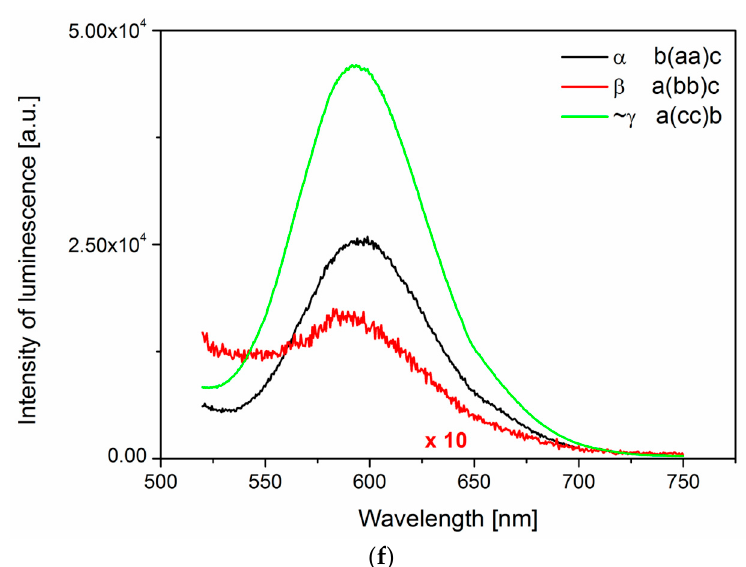
Figure 2. ( a ) Emission spectra of Mn 2+ for sample 3, T = 300 K and T = 7 K. ( b ) Emission spectra of studied samples, T = 7 K. ( c ) Emission spectra of of Mn 2+ for samples 3 and 14, primary and irradiated and heated, T = 7 K. ( d ) Polarized excitation spectra of Mn 2+ for sample 3, T = 300 K. ( e ) Polarized excitation spectra of Mn 2+ for sample 3, T = 7 K. ( f ) Polarized emission spectra of Mn 2+ for sample 3, T = 300 K.